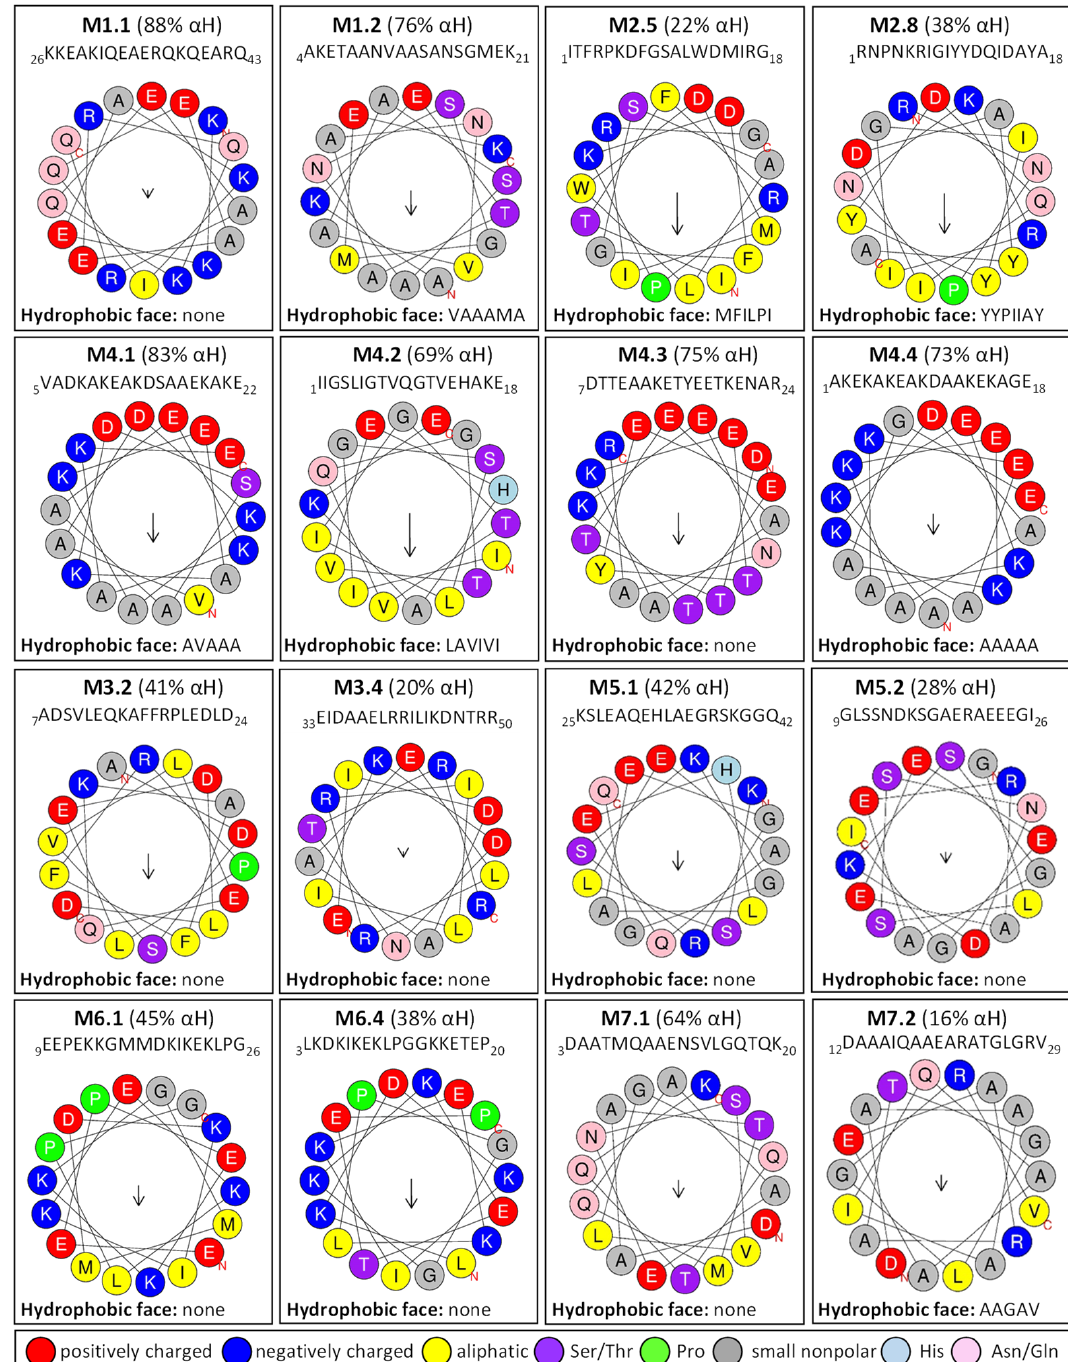
Figure 4. Modelling of the α -helix structure within detected MEME motifs in R. serbica LEA protein family members. Helical projections of α -helices were generated using the HeliQuest webserver [47]. α H; predicted α -helix percentages obtained by FELLS. Each wheel was obtained with an 11-amino acid window. The arrow shows the helical hydrophobic moment.